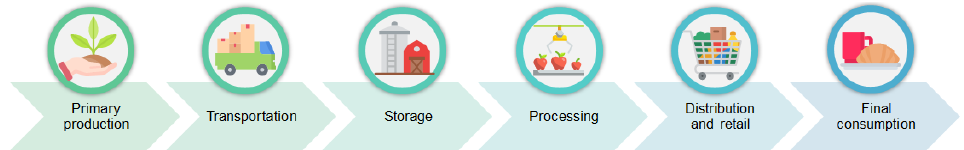
Figure 6. Schematic representation of a generic agri-food supply chain, from the producer to the final